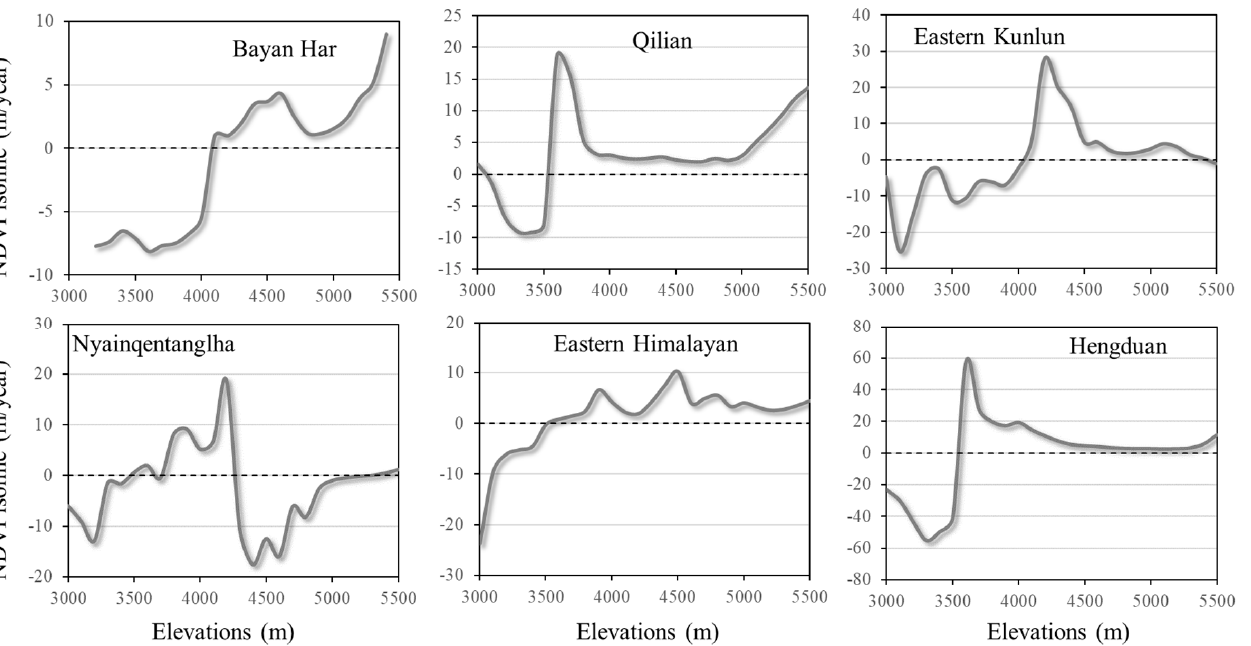
Figure 6. The speed of vertical movement of NDVI isoline for the elevation bins ( NDVI iso ( h ) , estimated from Equation (2)) in different mountainous regions.